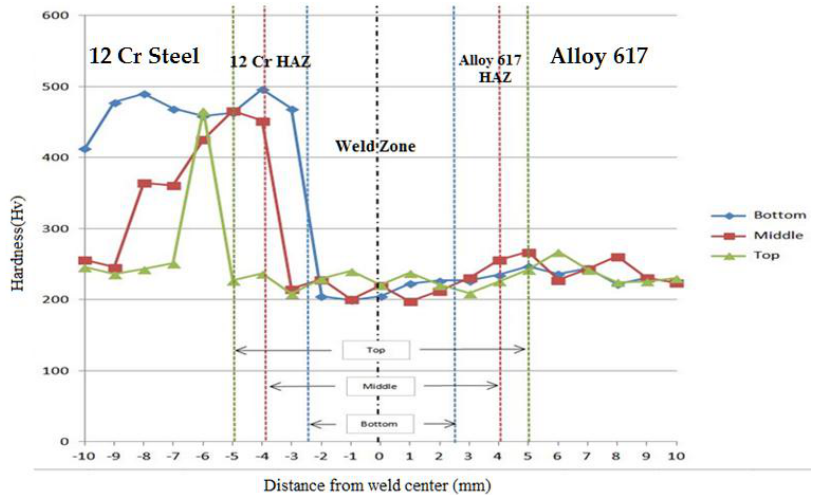
Figure 10. Micro hardness profile across the dissimilar metal welded joint.